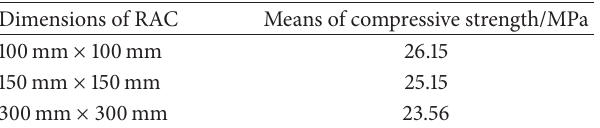
Figure 8: The average compressive stress-strain curves of RAC specimens in three dimensions. Table 3: The average uniaxial compressive strength of different sizes of RAC specimens.